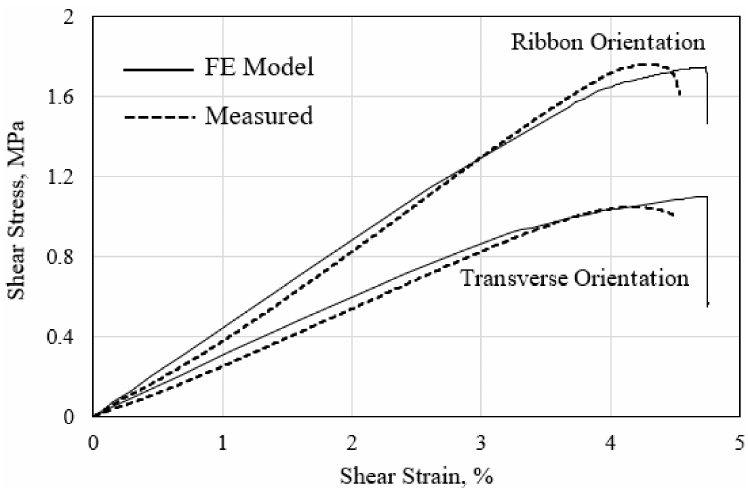
Figure 14. Comparison of the measured and FE-calculated out-of-plane shear stress–strain responses of the HC